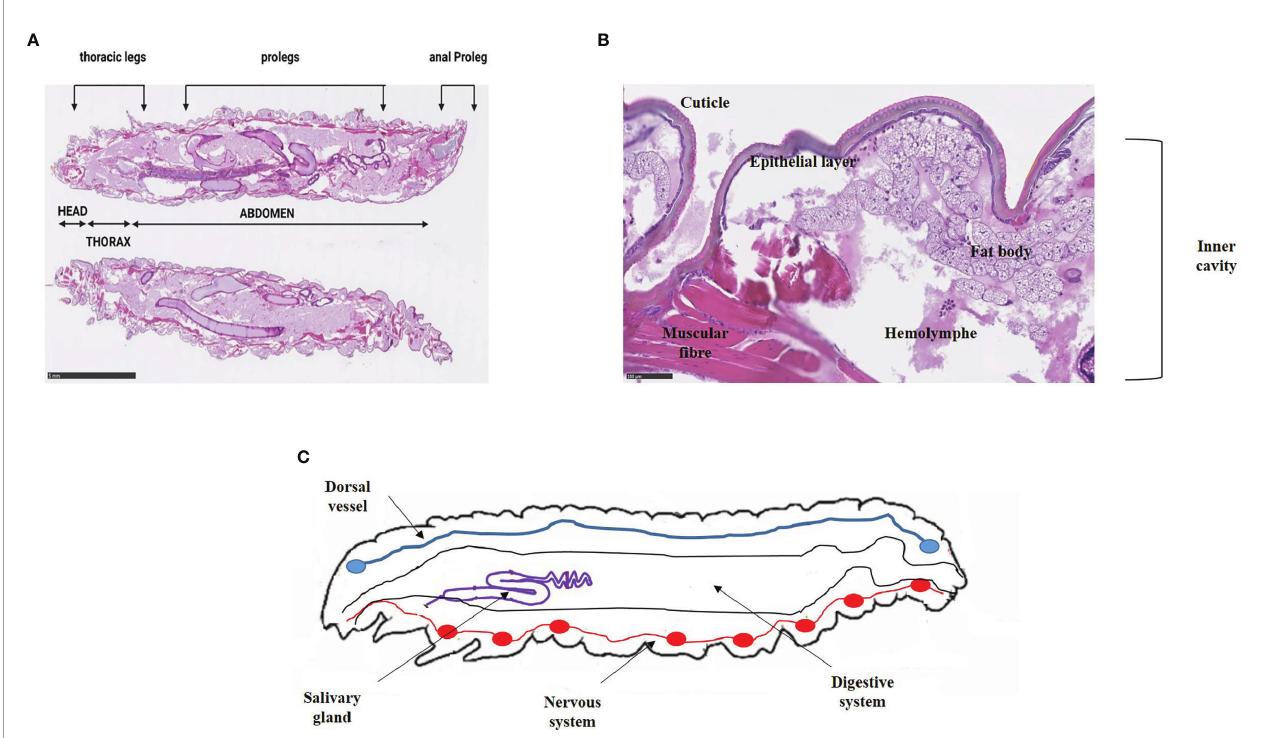
FIGURE 2 | Anatomy of ( G ) mellonella larvae. (A) External anatomy of G. mellonella larvae. The larval body is divided into 3 distinct parts e.g. head, thorax and abdomen. Prolegs are scattered on the thorax and the abdomen. (B) Integument system and inner cavity. The integumentary system includes the cuticle and a thin epithelial layer opening onto the inner cavity composed of the fat body and the hemolymph. Pictures are from our immunohistochemical analysis that obtained from non-infected larvae. Scale bar is indicated (Me ́ nard et al., 2021). (C) Anatomy of G. mellonella larvae (adapted from Durieux et al.,